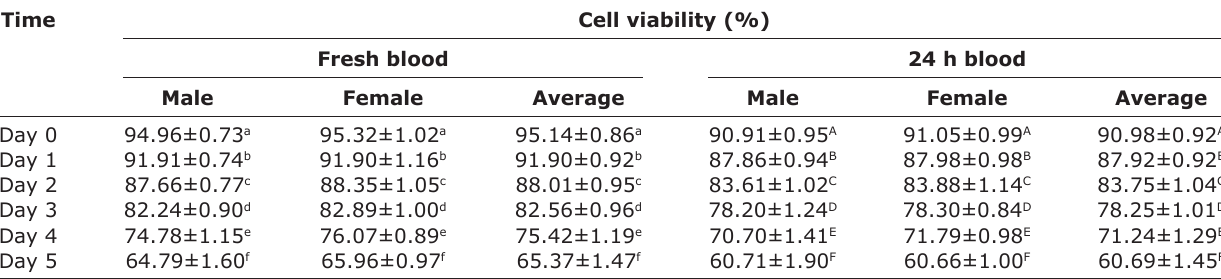
Table-4: The viability of peripheral blood mononuclear cells isolated from fresh and 24 h blood samples from Leghorn chickens